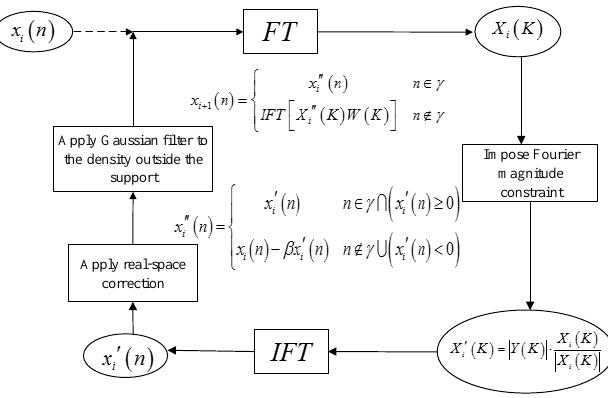
Figure 2. The schematic of the OSS phase retrieval algorithm.